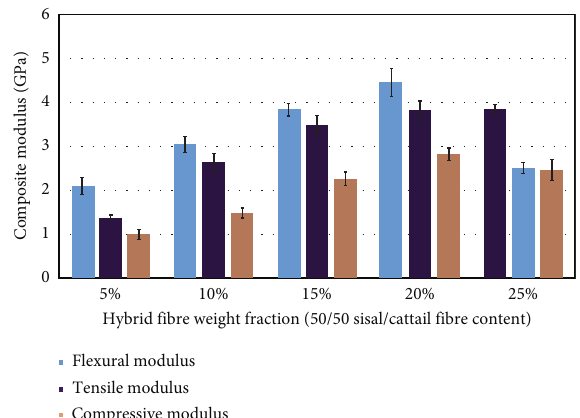
Figure 5: Flexural, tensile, and compressive moduli of hybrid composites at a constant fibre blend ratio of 50/50 and varying hybrid fibre weight fraction.